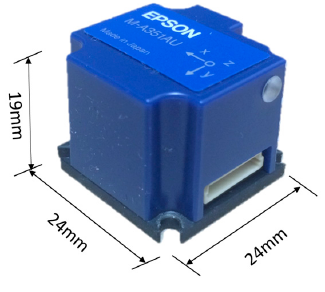
Figure 4. M-A351 accelerometer.